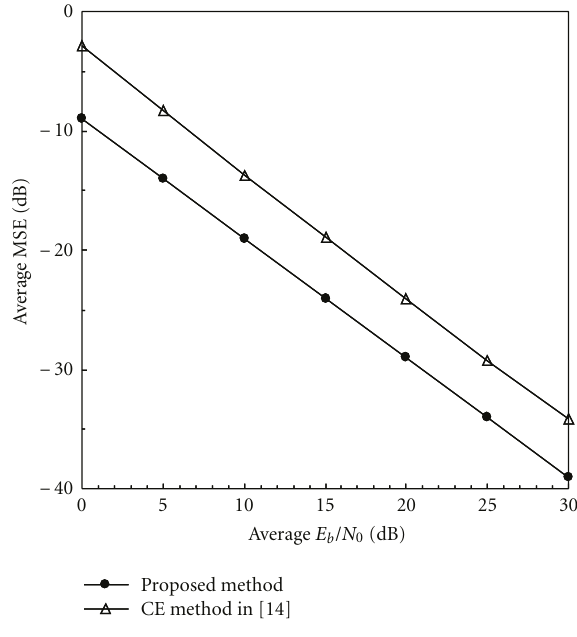
Figure 5: Average MSE versus E b /N 0